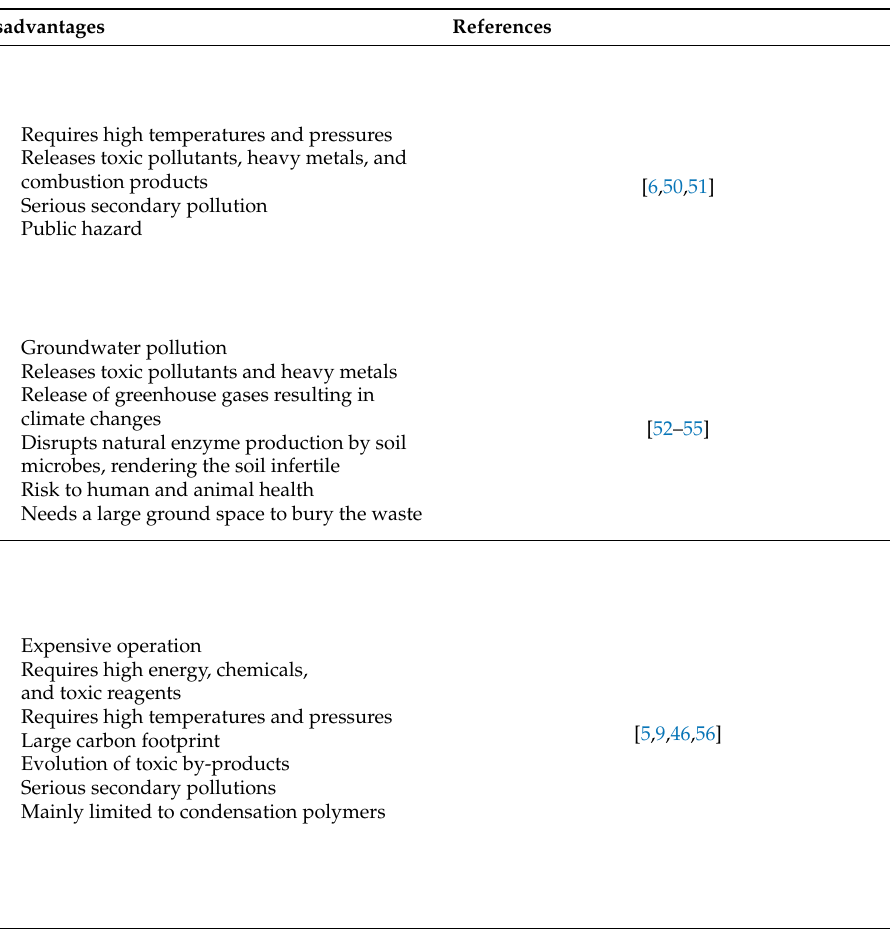
Table 1. Disadvantages of three different treatment methods and toxic pollutants produced during these